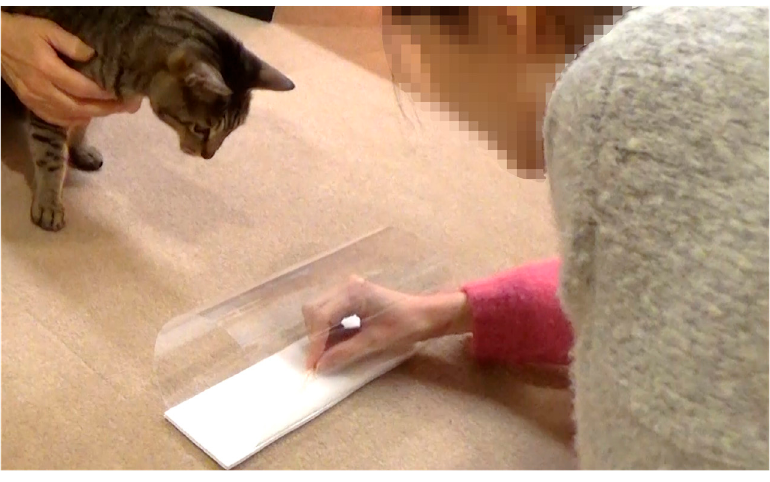
Figure 2. Set-up of the transparent tube task (Experiment